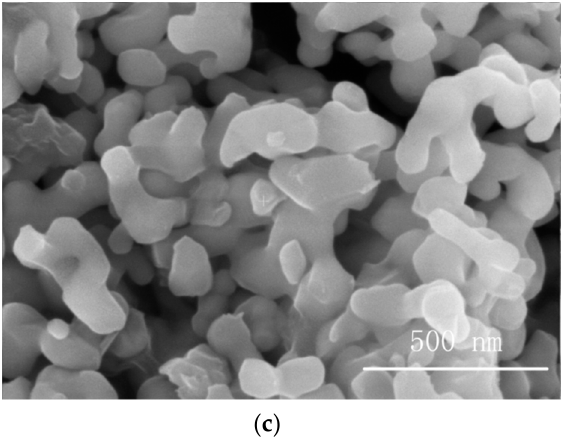
Figure 1. SEM images of ( a ) Al 2 O 3 -NPs, ( b ) Al 2 O 3 -NWs, and ( c ) Al 2 O 3 -NPLs.